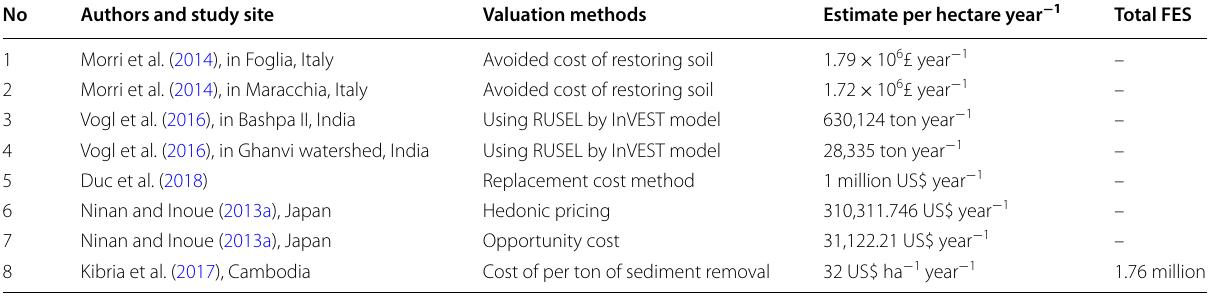
Table 6 Reviewed studies dealing with erosion regulation/sediment yields including its methodology and monetary